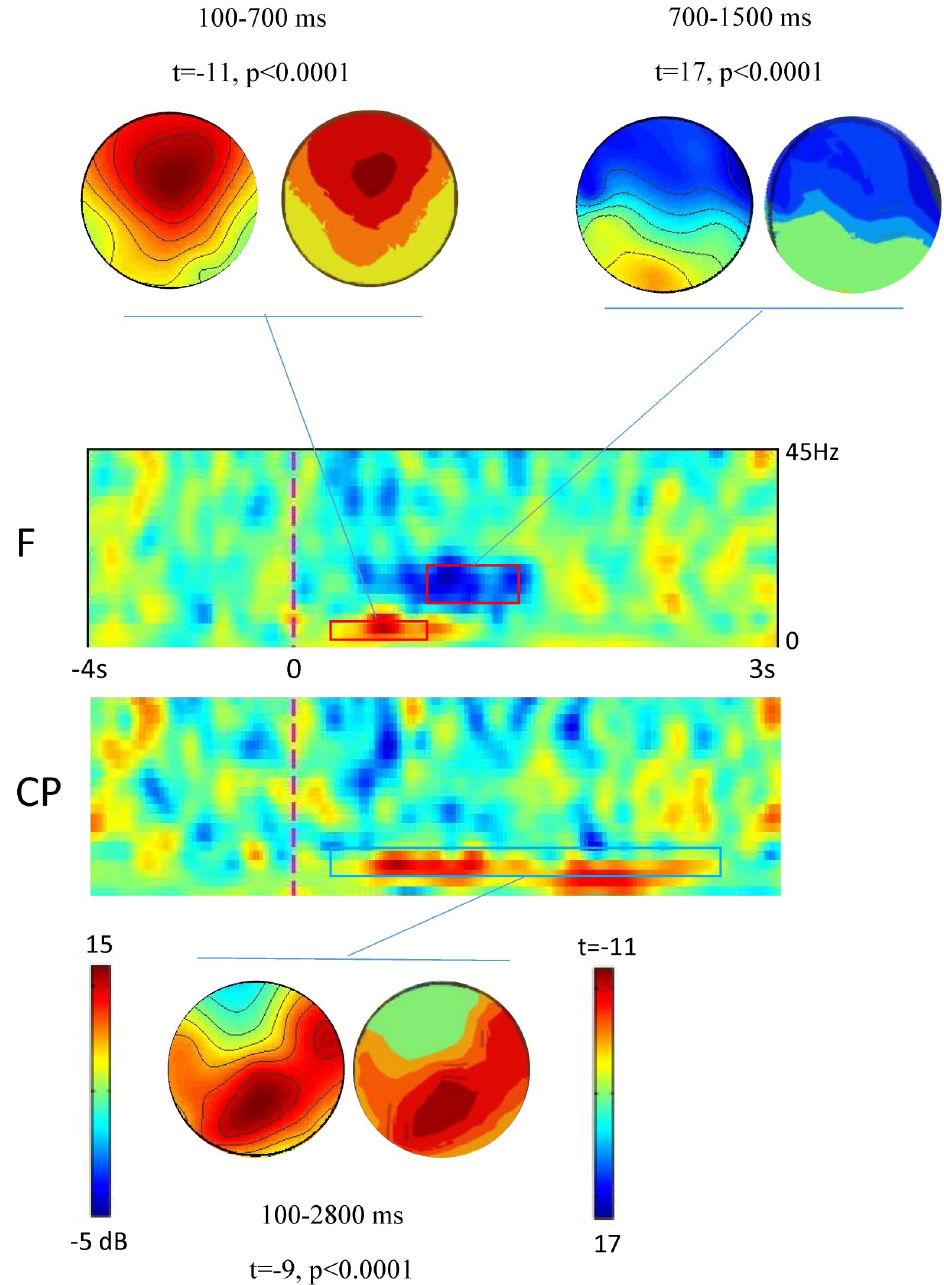
Fig 2. ERSP plots of pooled electrodes in frontal and centroparietal scalp sites. Electric stimulus onset is at 0ms. Pairwise headplots indicate the left the ERSP topography at specific periods, the right the two-dimensional grand mean t- maps (negative t- test value indicates a post-stimulus ERSP